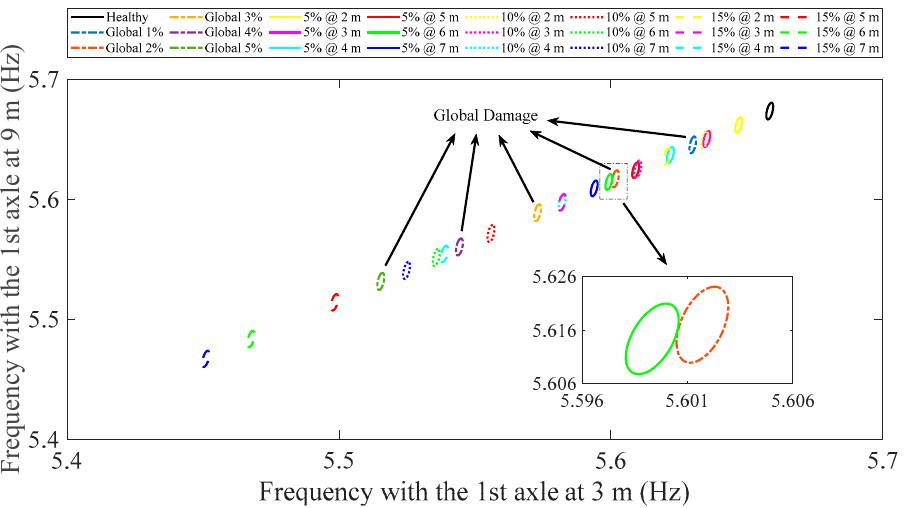
Figure 6. Bivariate distributions of bridge eigenfrequencies at 3 m and 9 m associated with a healthy bridge, 18 local stiffness losses (six different damage locations and three damage severities) and 5 global stiffness losses.